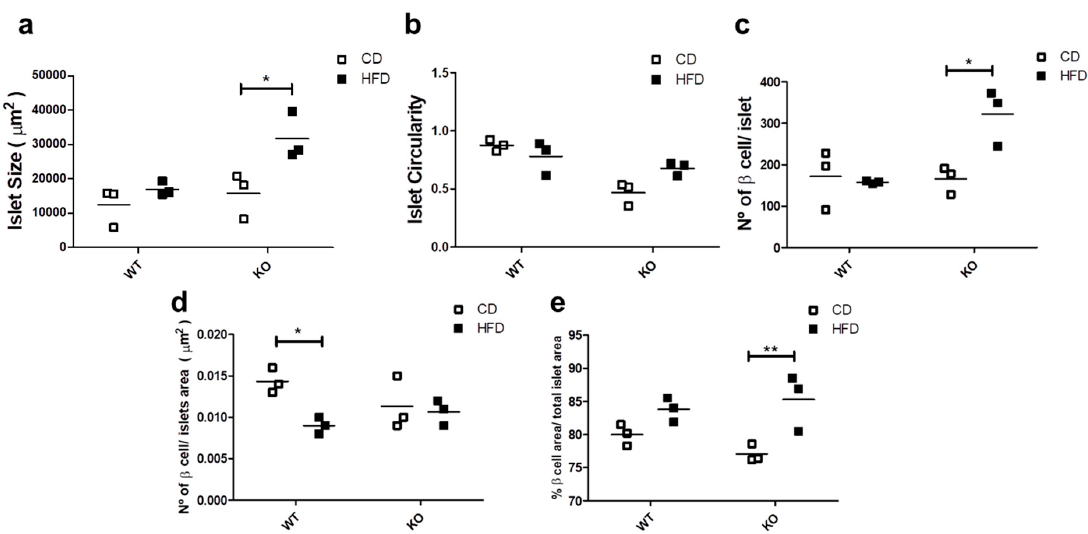
Figure 4. Study of islet morphology. After 12 weeks on CD or HFD, the pancreas was extracted, and 4 mm pancreas sections were stained with DAPI (4’,6-Diamidino-2-Phenylindole (double stranded DNA staining) and insulin-specific antibodies to identify the islets. In ( a ) the islet size, ( b ) the islet circularity, ( c ) the number of beta cells per islet, ( d ) the beta cell density in the islet and ( e ) the total beta cell area (%) per total islet area are shown. The results are representative of at least three sections per animal, with a total of at least three animals for each WT and KO group. p values were calculated by two-way ANOVA with a Bonferroni post-test (* p < 0.05, ** p < 0.01). Data are presented as individual data points with their respective means.